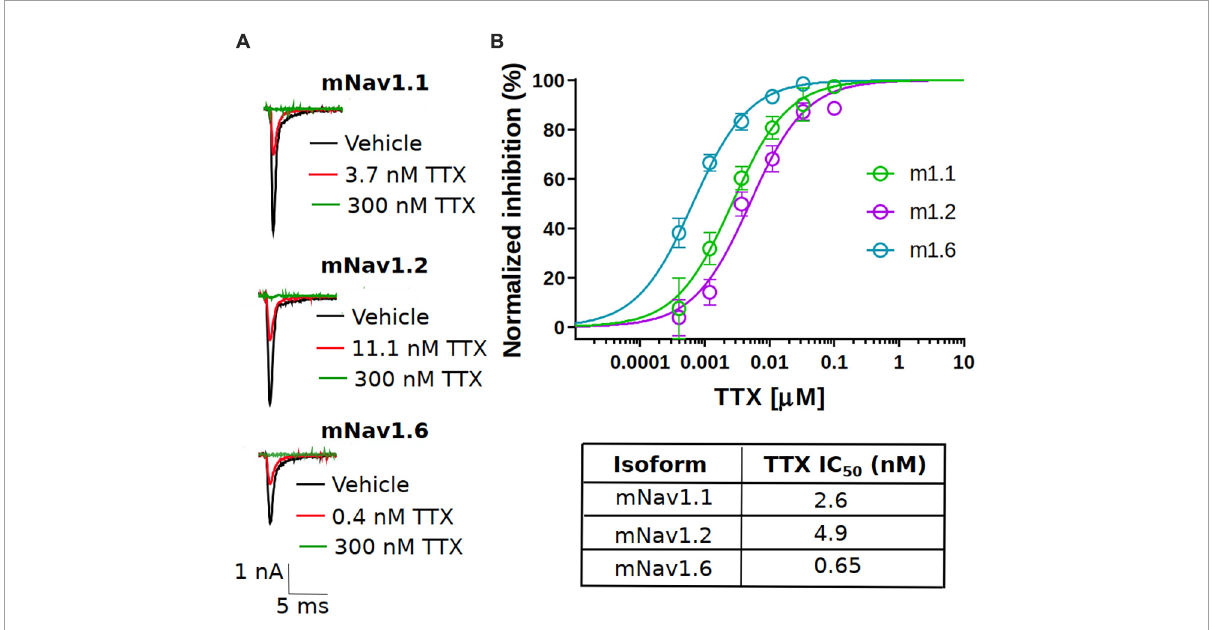
FIGURE1 Potency of TTX inhibition on the mouse neuronal Nav channels. (A) Representative traces of voltage-clamp recordings of vehicle (black) and the concentration close to the TTX IC 50 (red) for mouse Nav channel isoforms (mNav1.1, mNav1.2 and mNav1.6) heterologously expressed in HEK293 cells. For all the tested Nav channel isoforms, 300 nM TTX (green trace) showed complete block of Na + -current. (B) Concentration-response relationship for TTX inhibition of mouse Nav1.1, Nav1.2 and Nav1.6 channel isoforms. Each concentration represents the mean of n = 7–15 cells. The solid line is the best fit of the average data to the Hill equation yielding IC 50 = 2.6 nM for mNav1.1, 4.9 nM for mNav1.2 and 0.65 nM for mNav1.6.